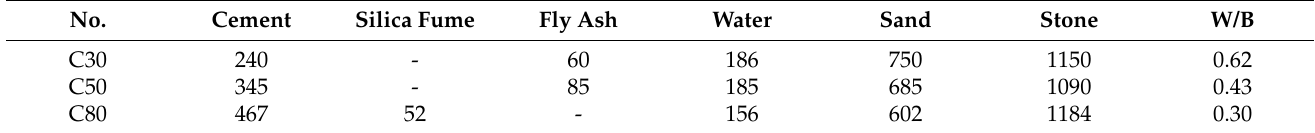
Table 2. Mix proportions of concrete, kg/m 3